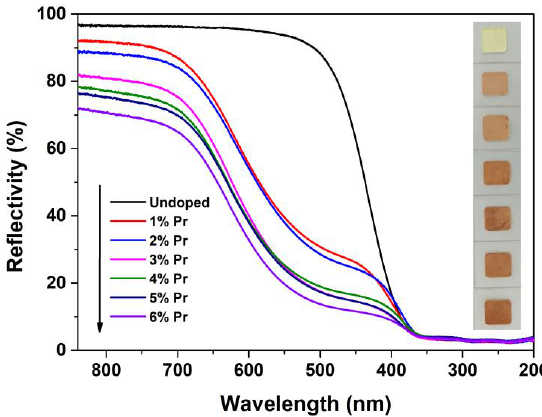
Figure 7. Reflectance spectra and photographs of Undoped CeO 2 and Pr−doped CeO 2 with different Pr contents.